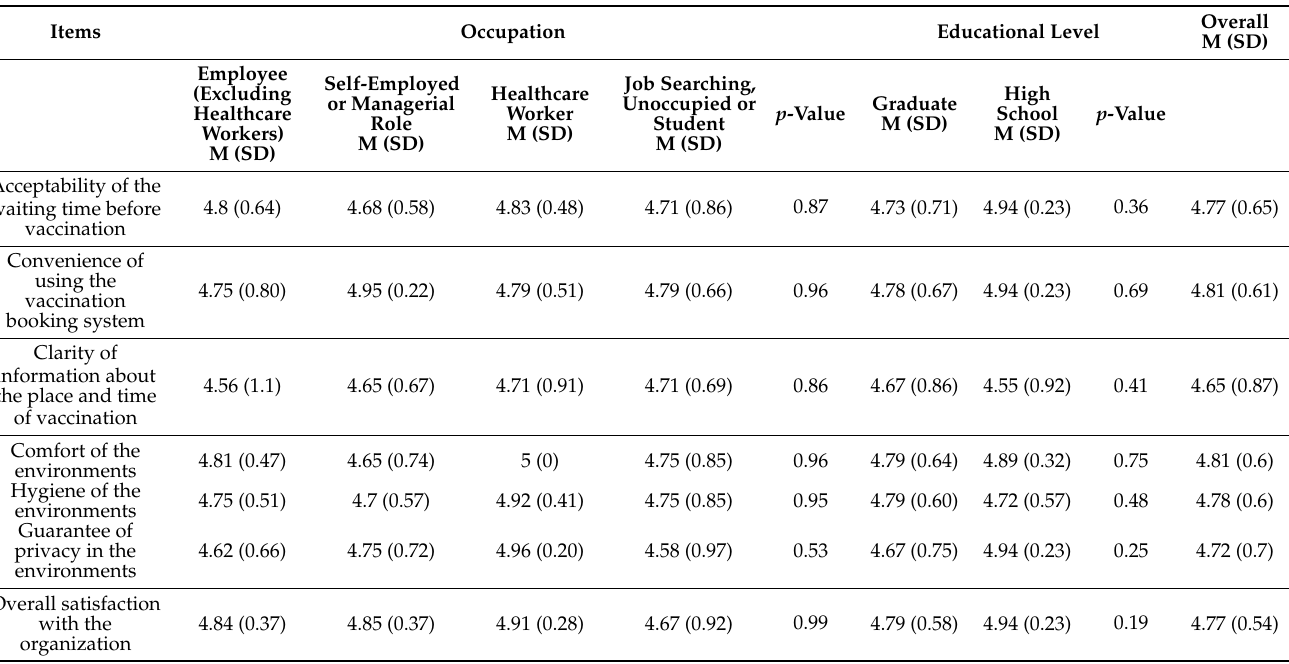
Table 2. Appreciation of the logistic organization of the vaccination services, related to occupation and educational level (N = 100).